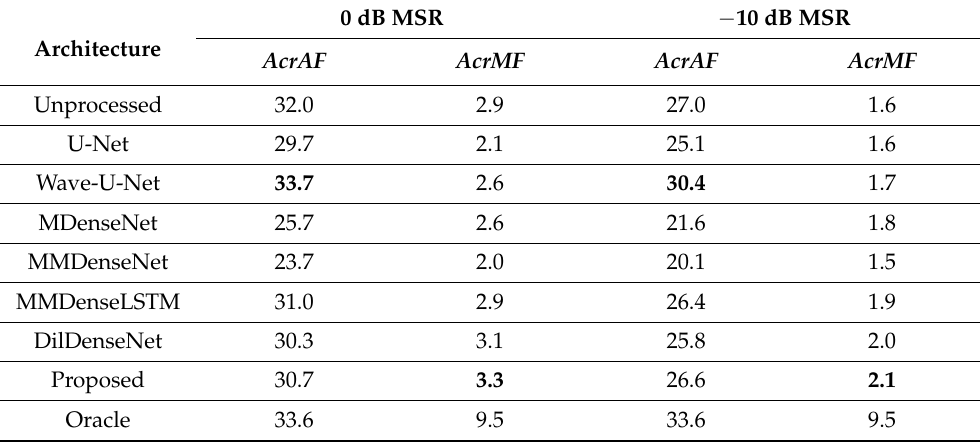
average number of matched fingerprints across the frequency boundaries ( AcrMF